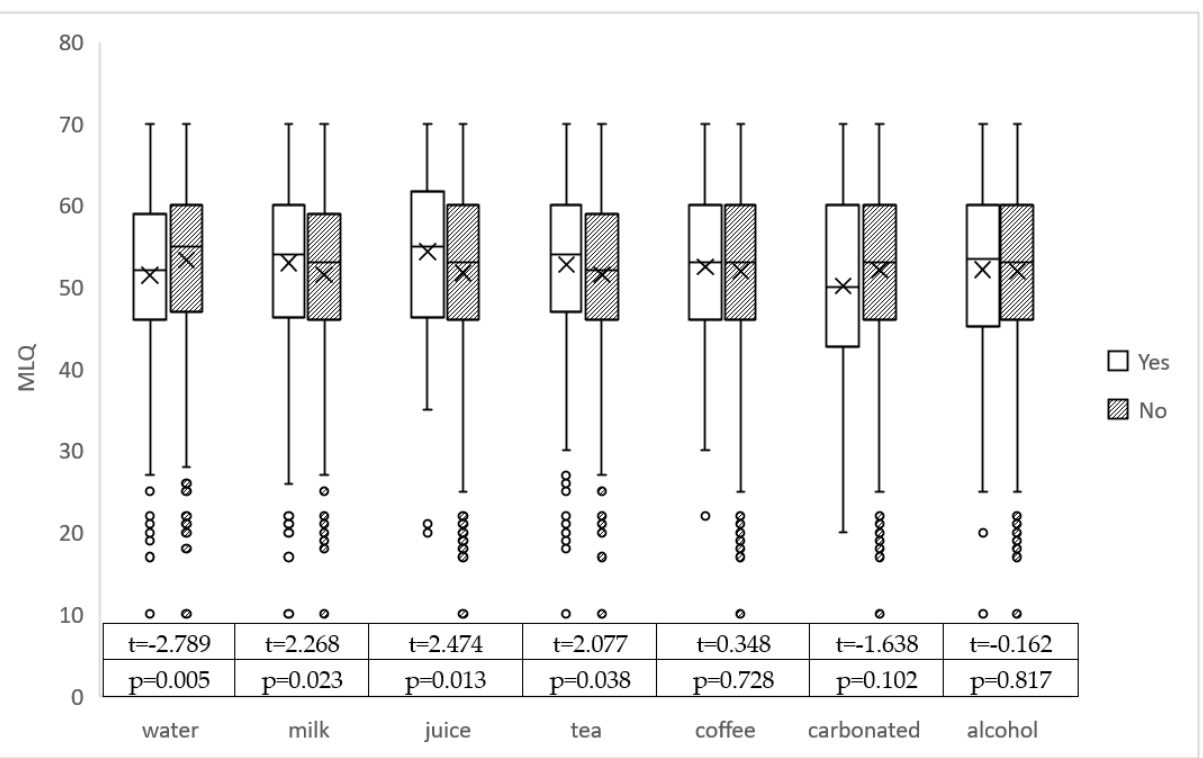
Figure 1. Box plot of the association between drinking behaviors and meaning in life. Finally, we conducted multiple linear stepwise regression to identify the factors associ- ated meaning in life in Table 3. After controlling for depression, the results supported that the older age ( β = 0.098, p = 0.001), preventive medicine majors ( β = 4.281, p = 0.013), work- ing fewer days per week ( β = − 0.942, p = 0.004), licensed (assistant) technician qualification ( β = 2.921, p = 0.036), no depression ( β = − 0.203, p < 0.001), not drinking water